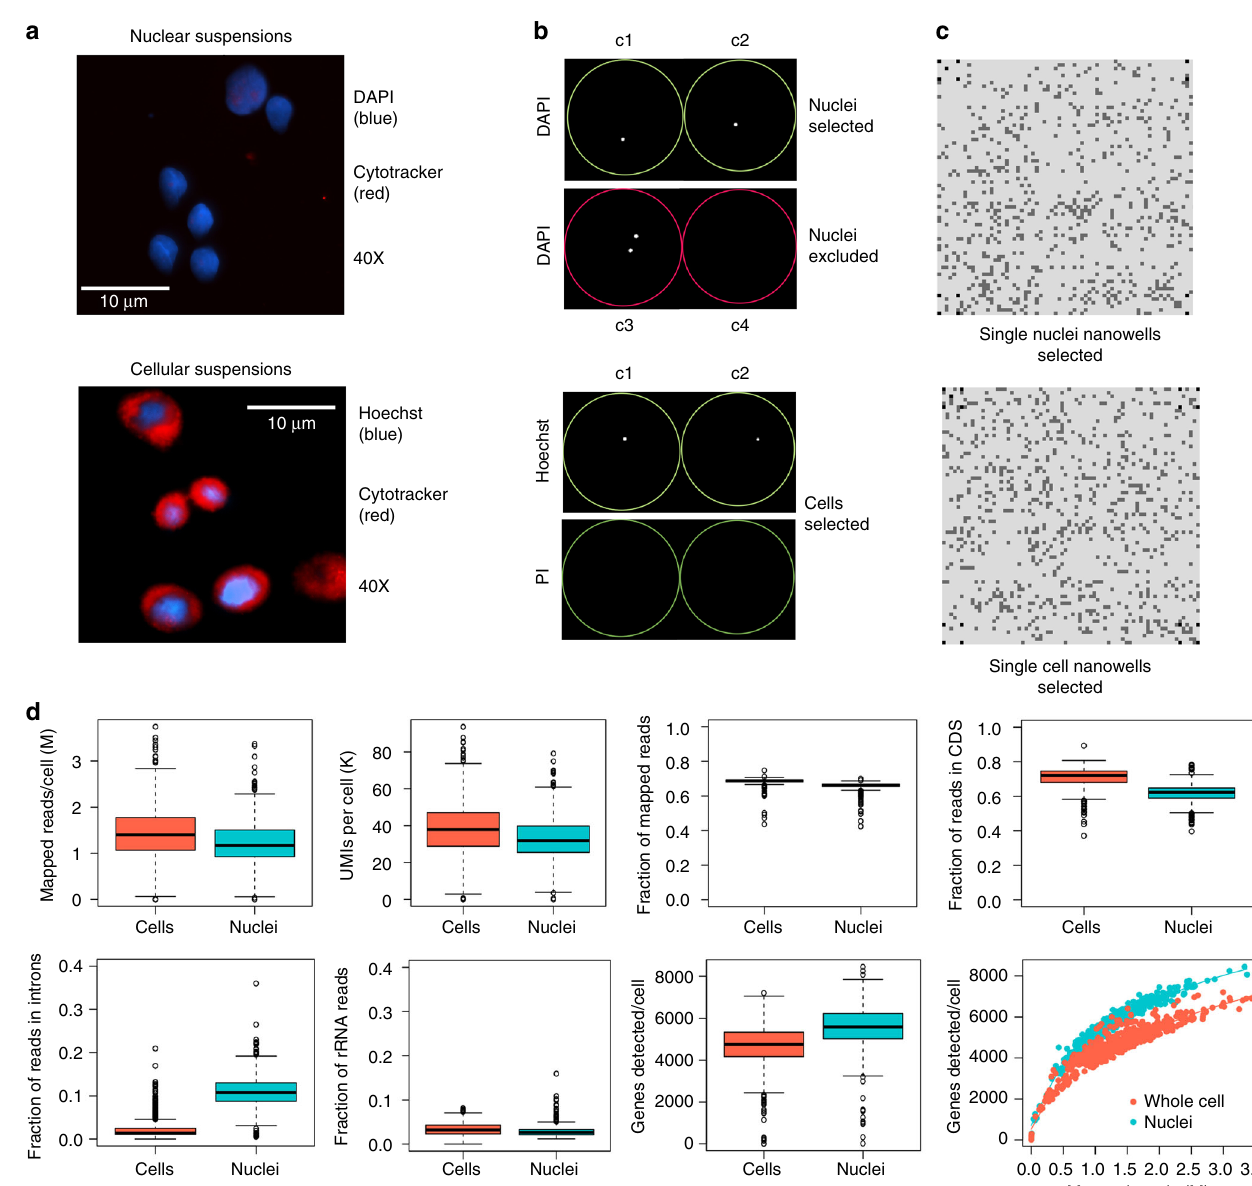
Fig. 3 Imaging and data metrics of single SK-BR-3 nuclei and cells. a Nuclear suspensions were stained with DAPI ( blue ) and cytotracker ( red ), while cellular suspensions were stained with Hoechst ( blue ) and cytotracker ( red ) for fl uorescent microscopic imaging at ×40 magni fi cation to visualize the nucleus and cytoplasm. The 100 μ m scale bar indicates the cell size as a reference. b Nanodispensed nuclei and cells were imaged in nanowells using DAPI, or Hoechst and PI c Nanogrid maps of cells or nuclei that were selected for RNA-seq. d Sequence data metrics were calculated for single nuclei and single cells from the SK-BR-3 breast cancer cell line, where the boxes indicated the 75% interquartile range and whiskers showed the default values of the boxplot , with N = 485 for single nuclei and N = 424 for whole